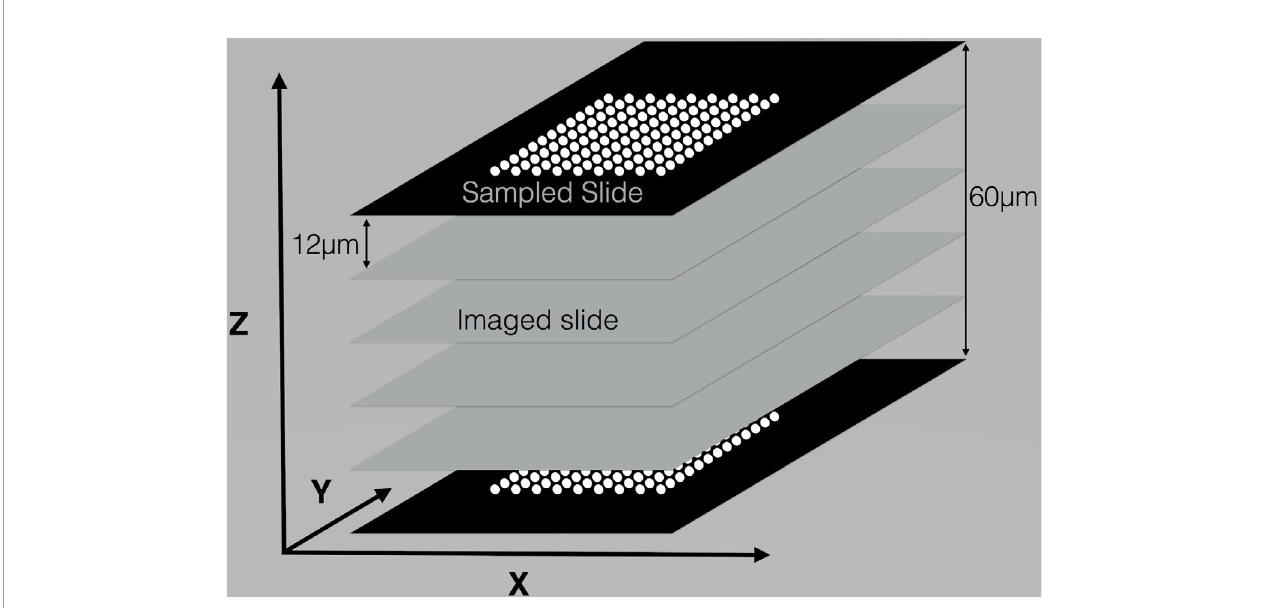
FIGURE 1 | Schematic representation of sampling procedure. The sampled slides are placed on LCM membranes, and 96 samples are taken in the form of an 8 × 12 grid. One slide per 5 is sampled, and the ones in-between are placed on glass slides for imaging. The above schema has been repeated for a total of 70 slides of which s = 14 are sampled and 56 are only imaged. The total number of samples is